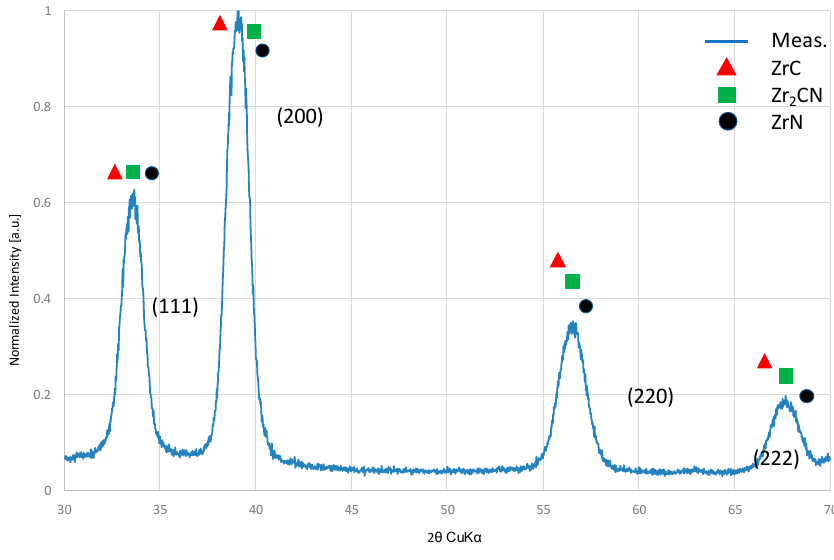
Figure 7. Example of GIXRD spectrum of a ZrCN coating.